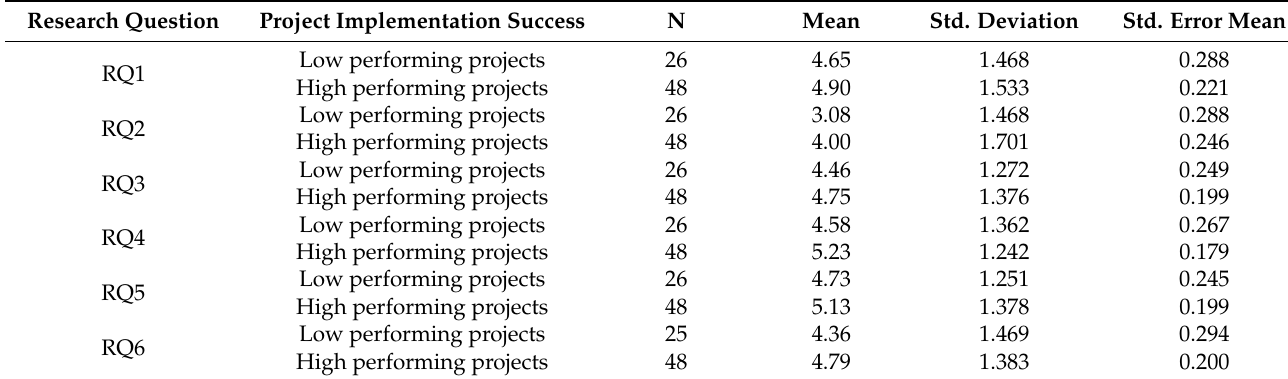
Table 2. Group statistics according to RQ.